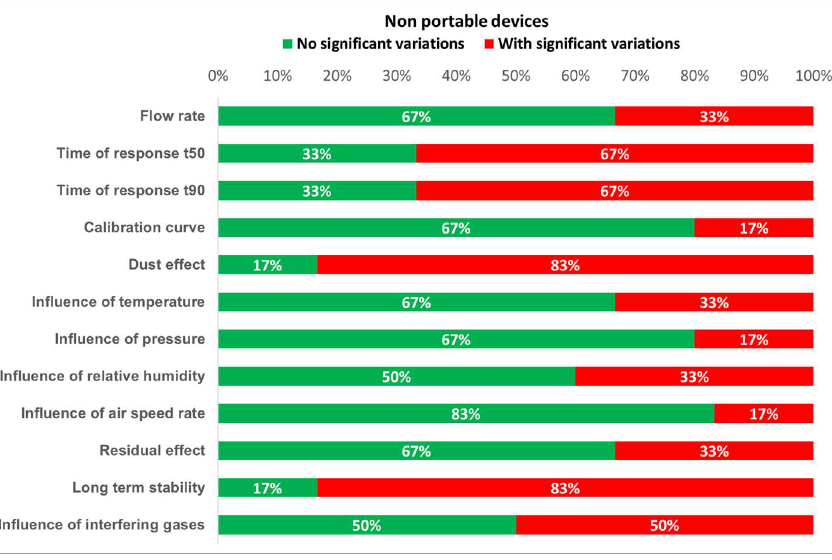
Figure 17. Detected variations for portable devices. Furthermore, the worst results for both portable and non-portable equipment are produced when testing time of response, relative humidity, dust effect, and interfering